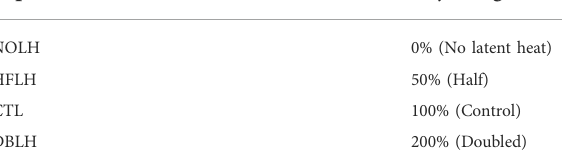
TABLE 1 Descriptions of the sensitivity